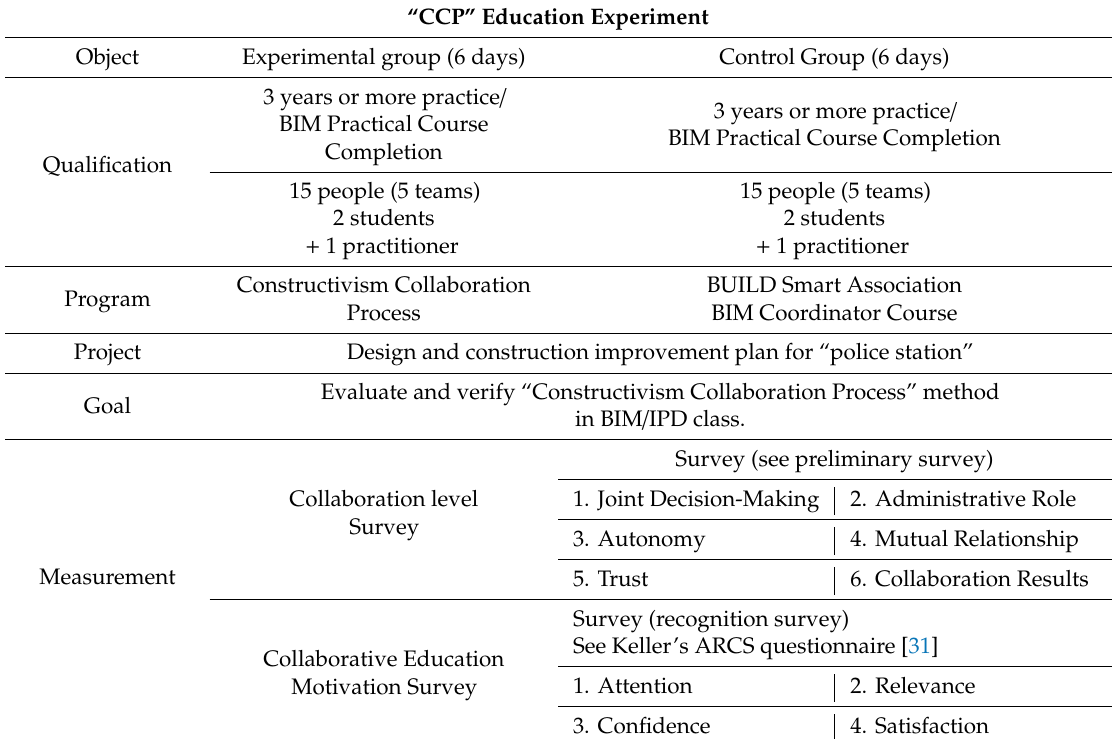
Table 4. BIM collaborative education lab overview.